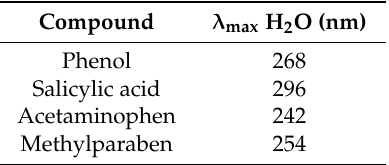
Table 3. Maximum wavelengths of the